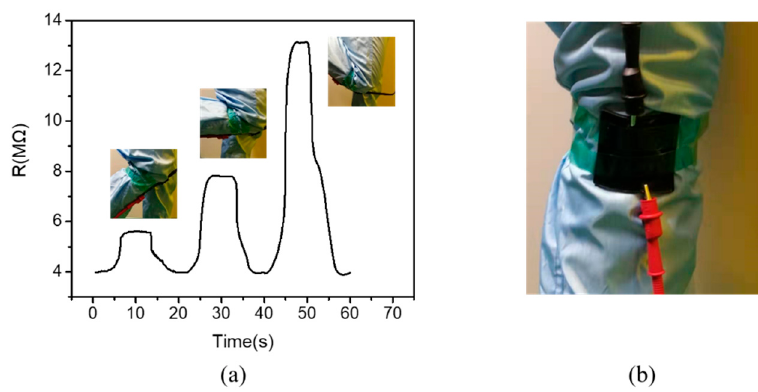
Figure 6. ( a ) Corresponding effect of the film on the knee joint bending at 45°, 90°, and 135°. ( b ) Schematic diagram of the film clamped on the knee.